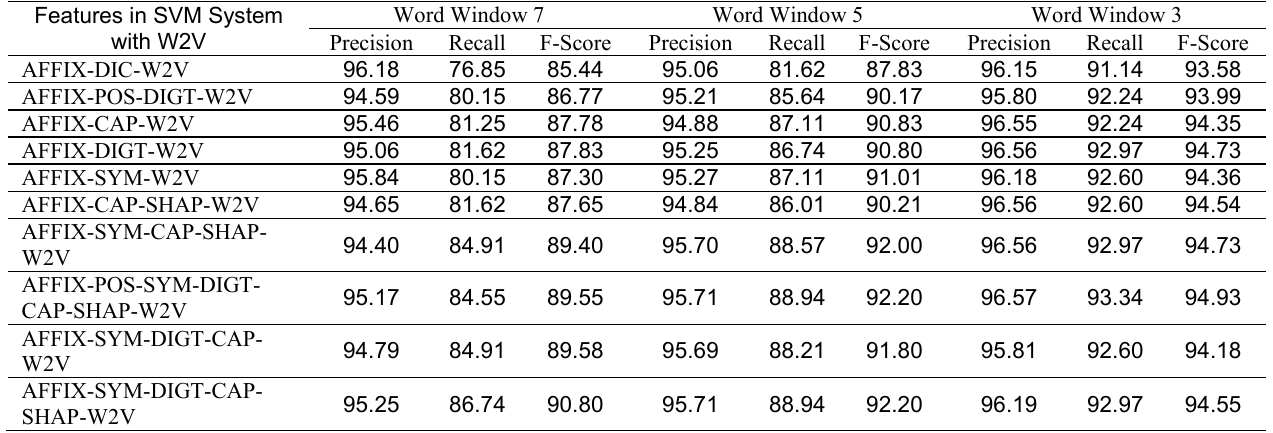
Table 5. Result of SVM Based NER System with Word